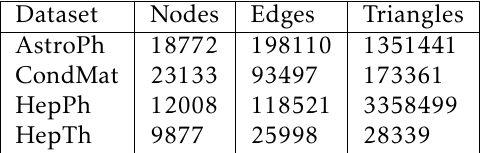
Table 1. Statistics of used